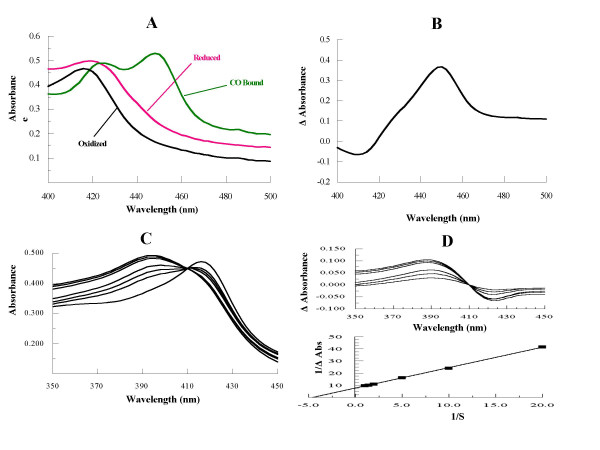
CYP110 Absorbance Spectra, Titrated Spectral Shift, and Double Reciprocal Plot in the presence and absence of various hydrocarbons. The absorbance characteristics were monitored for the purified soluble CYP110 from E. coli. The sample was diluted 1:5 in buffer A with 0.2 % deoxycholate. To reduce the P450, 5 mg of sodium dithionate was added to the sample. Carbon monoxide was then bubbled into the sample for 30 seconds. Panel A. Oxidized, reduced and carbon monoxide bound spectra. Panel B. Carbon monoxide difference spectrum with a peak at 450 nm. Panel C. The oxidized spectra for 3 μM CYP110 in buffer A + 0.2 % deoxycholate and titrated with tetradecanoic acid. The concentrations of tetradecanoic acid shown are 0, 0.1, 0.2, 0.5, 0.7, and 1.0 mM. Panel D. (Top) The difference spectra generated for CYP110 when titrated with tetradecanoic acid. The bottom plot for Panel D shows the spectrum without fatty acid subtracted from each spectra with fatty acid. The double reciprical plot of 1/ΔAbs vs 1/S is shown and the X-intercept is calculated by linear regression. Ks is defined as -1/X-intercept. ΔAbs for each fatty acid concentration is defined as the resulting value at 388 nm.